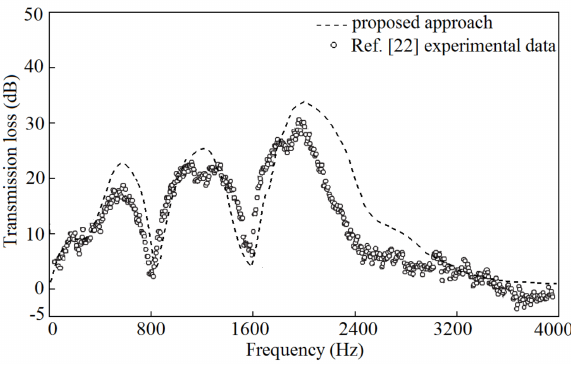
Figure 5. Comparison of the predicted and measured TL for Pattern 1 ( M = 0.2, T = 288 K).